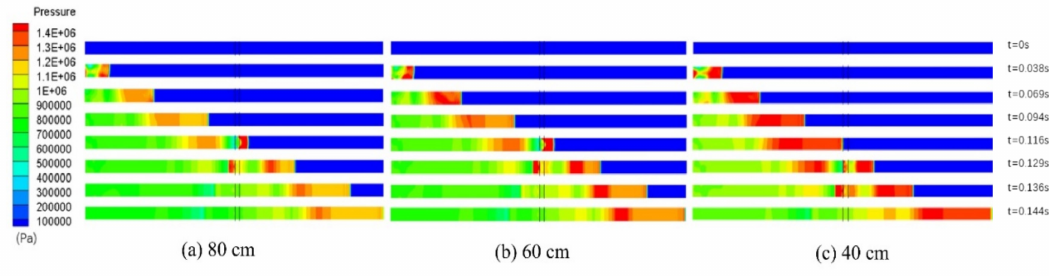
Figure 7. Comparison of pressure cloud of foam metal with different